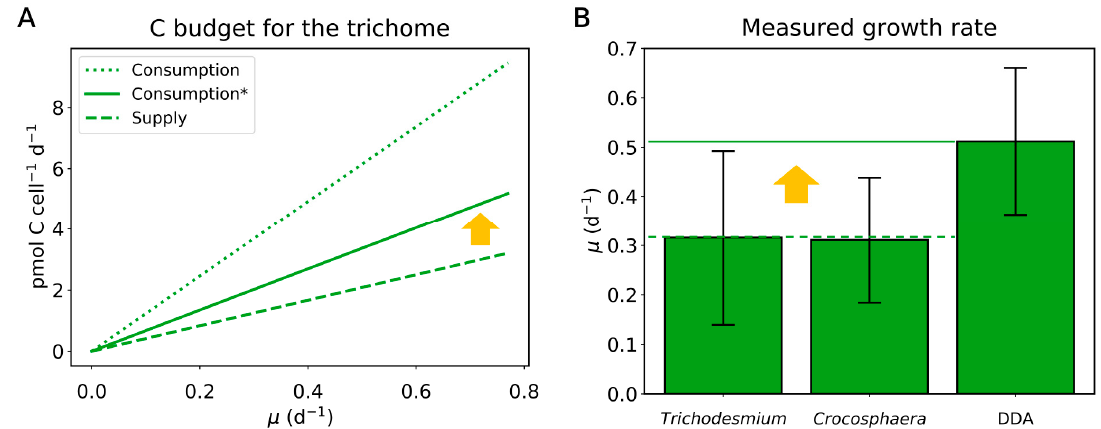
Figure 4. Simulated C budget for the Richelia trichomes and measured growth rates. ( A ) Cost and supply of C by the trichome per diatom ( Hemiaulus ) cells. Consumption* indicates the consumption of C that ignores the C consumption for N 2 fixation for diatoms. ( B ) Measured growth rates of marine free-living diazotrophic cyanobacteria and DDAs (compiled by Follett et al., 2018) [31].